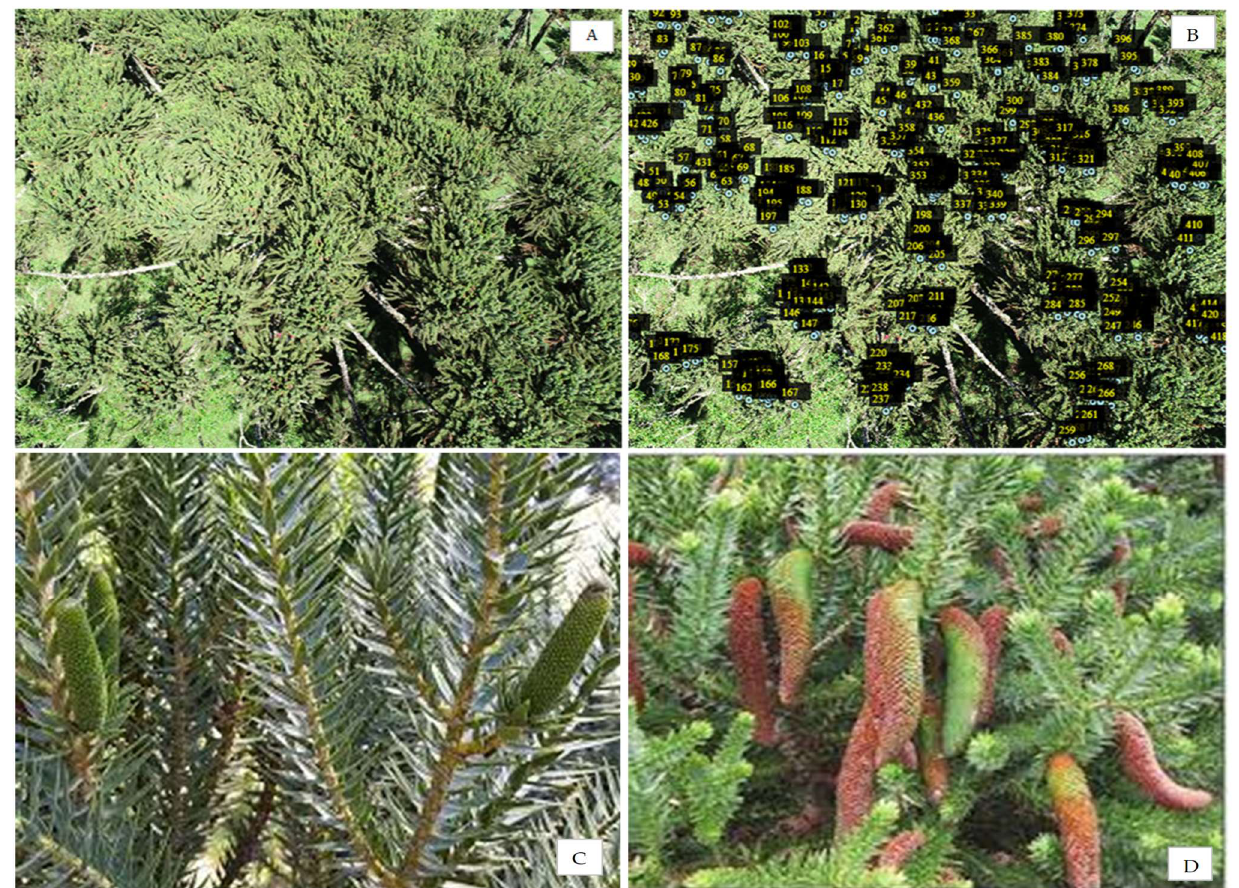
Figure 2. ( A ) The subset of an aerial image of the A. angustifolia crown obtained with controlled drone flight; ( B ) the spatial distribution of male strobili on the same subset using VGG Image Annotator Platform; ( C ) immature male strobili and ( D ) mature male strobili. Source: Authors ( A , B ); Katia Pichelli1 (https://www.minutorural.com.br/noticia/1217/pesquisa-desenvolve-araucarias-macho-que-produzem-polen-em-menos-da-metade-do-tempo. Accessed on 10 October 2022.) ( C ), Wendling and Zanette [30] ( D ). A perspective view of the study area and the crown structure is shown in Figure 1.